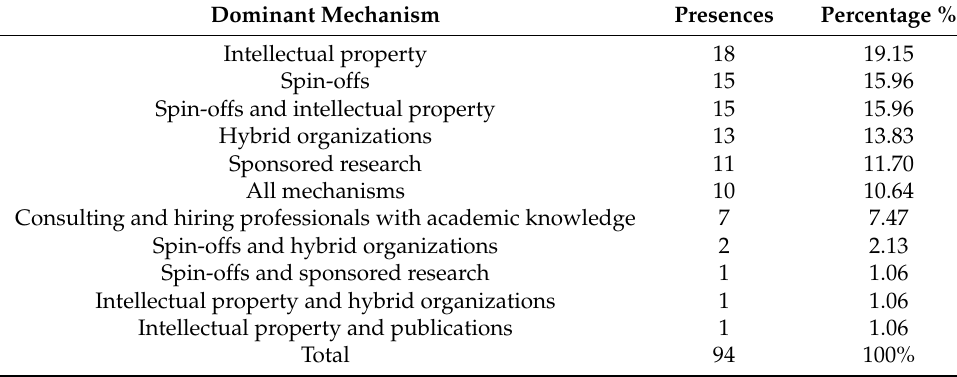
Table 4. Dominant